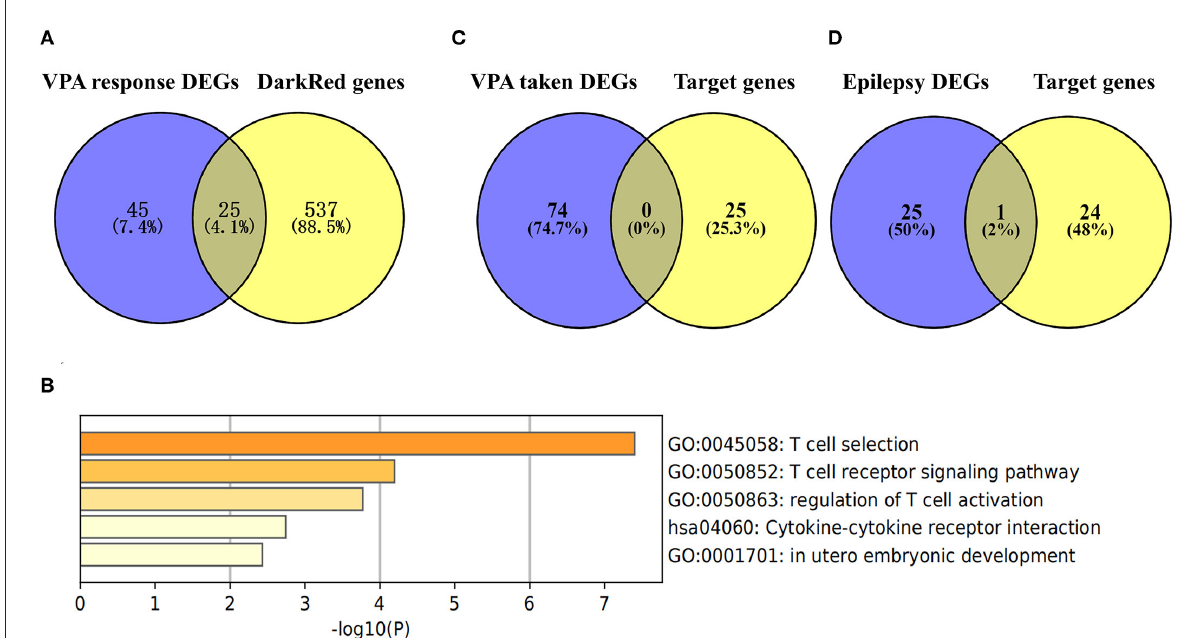
FIGURE6 Identification of target genes in the key module and bio-function analysis. (A) Common genes of DEGs in VPA resistance (the blue circle) and the significant genes in the darkred module (the yellow circle). The DEGs in VPA resistance were obtained using the “Limma” algorithm by |Log2 FC| > 0.5 and p- value < 0.05. The darkred module was most related to VPA resistance through WGCNA analysis and the significant module genes were those with p- value of gene significance in VPA resistance less than 0.05. By comparing the genes, a total of 25 target genes were obtained. (B) The function of the 25 target genes was analyzed by Metascape and top 5 clustered terms were displayed. (C) Common genes of target genes and VPA taken DEGs (the blue circle). (D) Common genes of target genes and epilepsy DEGs (the blue circle) [“Log10(P)” is the p -value in log base 10. DEG, differentially expressed gene; VPA, valproate; WGCNA, weighted gene co-expression network